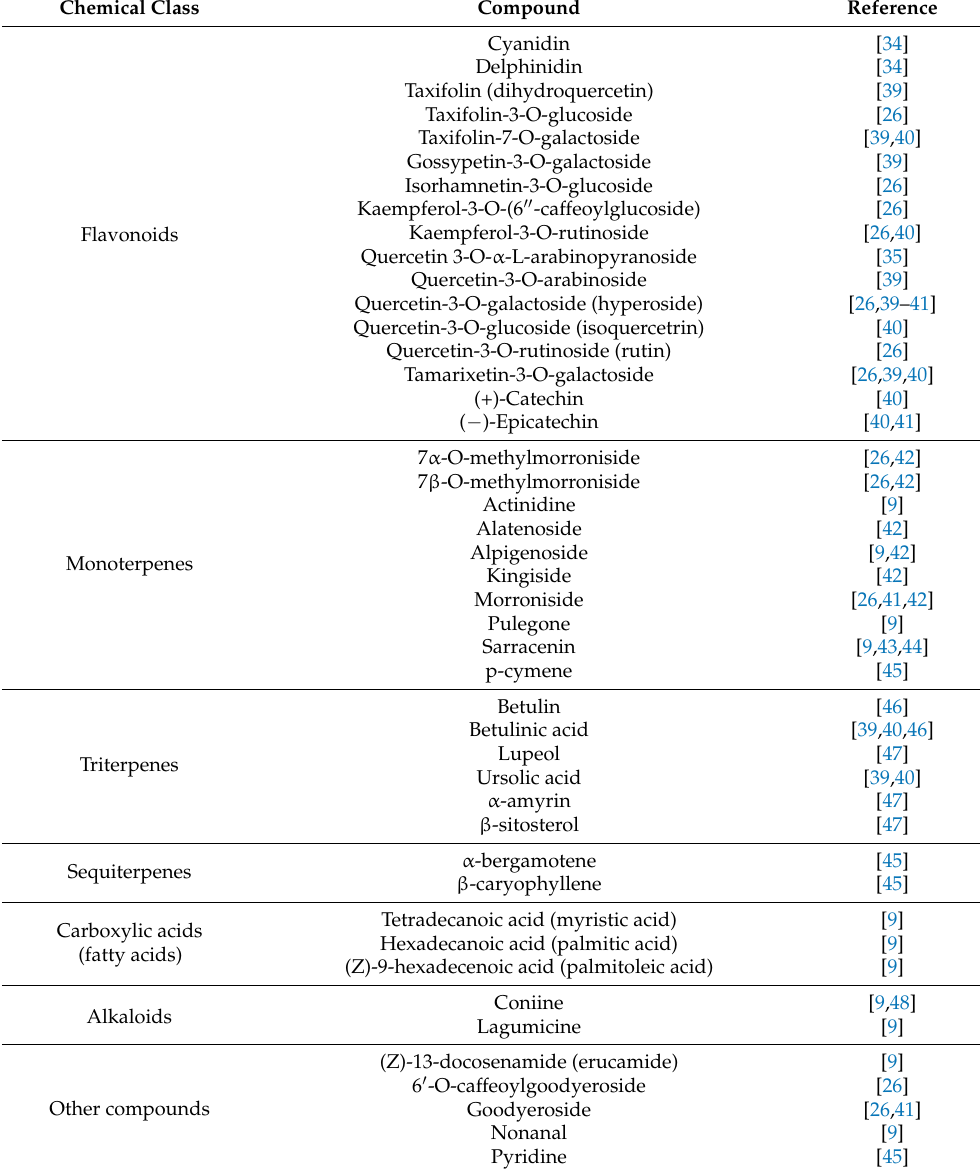
Table 1. Secondary metabolites detected in plants from the Sarraceniaceae